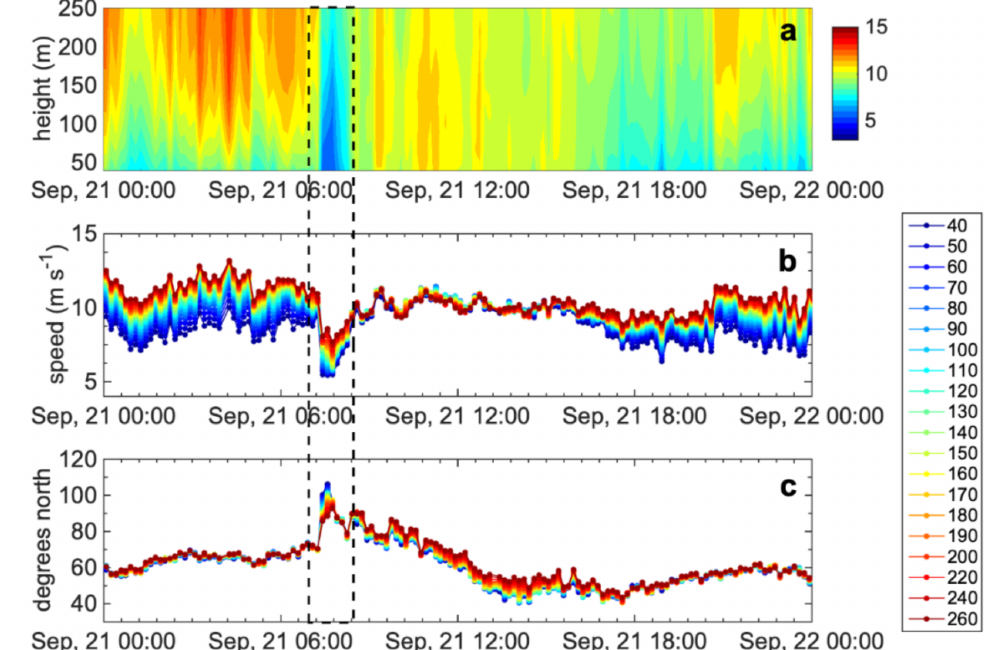
Figure 12. Data time series: ( a ) Magnitude of wind speed (m s − 1 ) based on 20 observations of LIDAR with height (40 to 260 m). Vertical profile of ( b ) wind speed (m s − 1 ), and ( c ) direction (degrees). Here the angle represents the direction that the wind is blowing from (in reference to the true north). Time is expressed in local